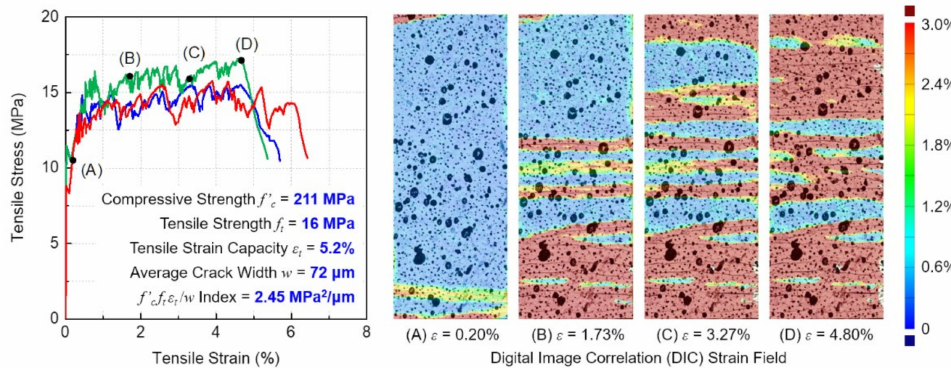
Figure 2. Tensile stress–strain relation and DIC strain field of strain-hardening UHPC with a combi- nation of PE fibers and steel fibers developed by Huang et al., (2021). (Reproduced with permission from [29]).